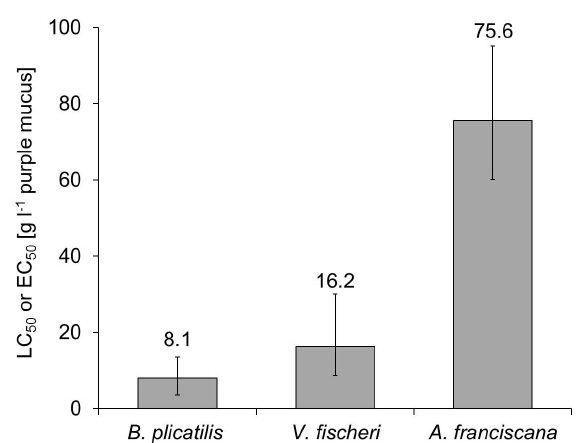
Fig. 3. – Median lethal/effect concentrations (LC 95% confidence intervals) estimated for Brachionus plicatilis (Ro- toxkit ® , 24 h), Vibrio fischeri ( Microtox ® , 15 min) and Artemia franciscana (Artoxkit ® , 24 h) after exposure to the frozen purple mucus produced by Halla parthenopeia (pool